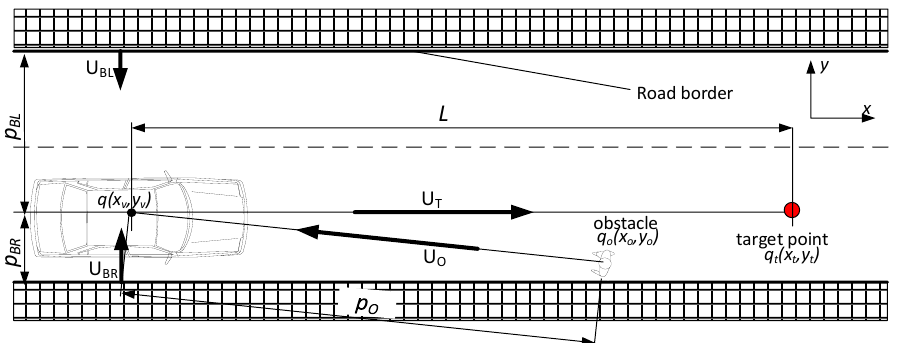
Figure 2. Scheme of interactions in the potential field .